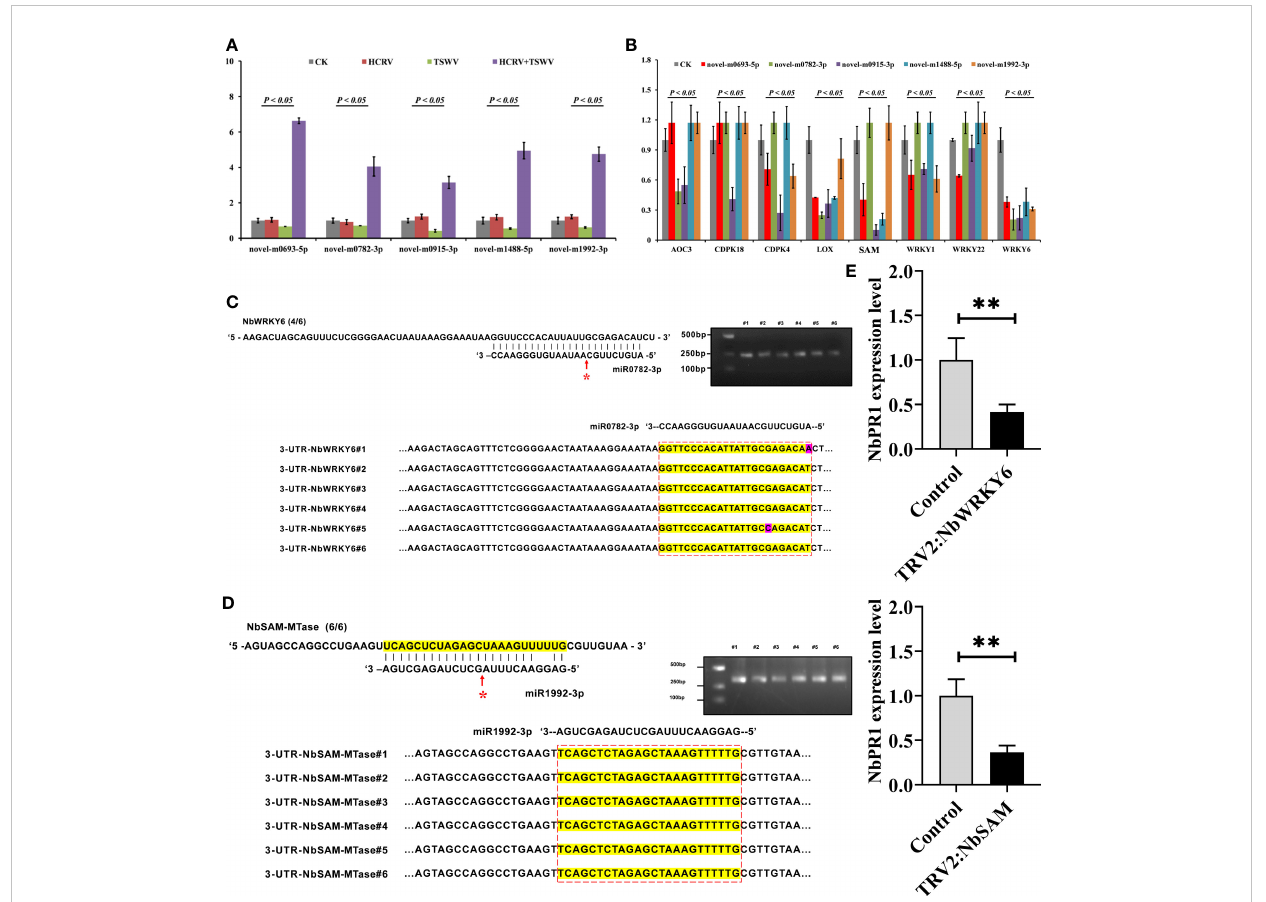
FIGURE 7 miRNA triggered by the TH complex directly binds to the promoters of NbSAM and NbWRKY6 to suppress the NbPR1-related resistance in tobacco. (A) The expression levels of the top fi ve miRNAs from the hub network are detected using RT-qPCR. (B) RT-qPCR assay detects the expression levels of resistance genes triggered by individual viruses in tobacco with overexpression of hub miRNAs. (C,D) Novel-m0782-3p and miR1992-3p cleavage sites in NbWRKY6 and NBSAM mRNAs validated by 5 ’ RLM-RACE, respectively. (E) RT-qPCR determines the expression level of NbPR1 in tobacco with the silencing of individual NbSAM and NbWRKY6 . ** P <